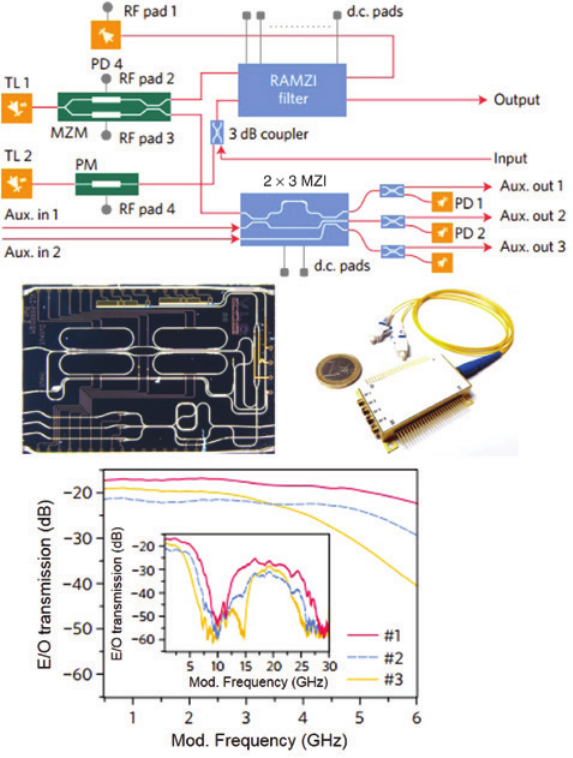
Figure 18: A monolithic integrated photonic microwave filter in InP [28] (Copyright in 2017, Nature